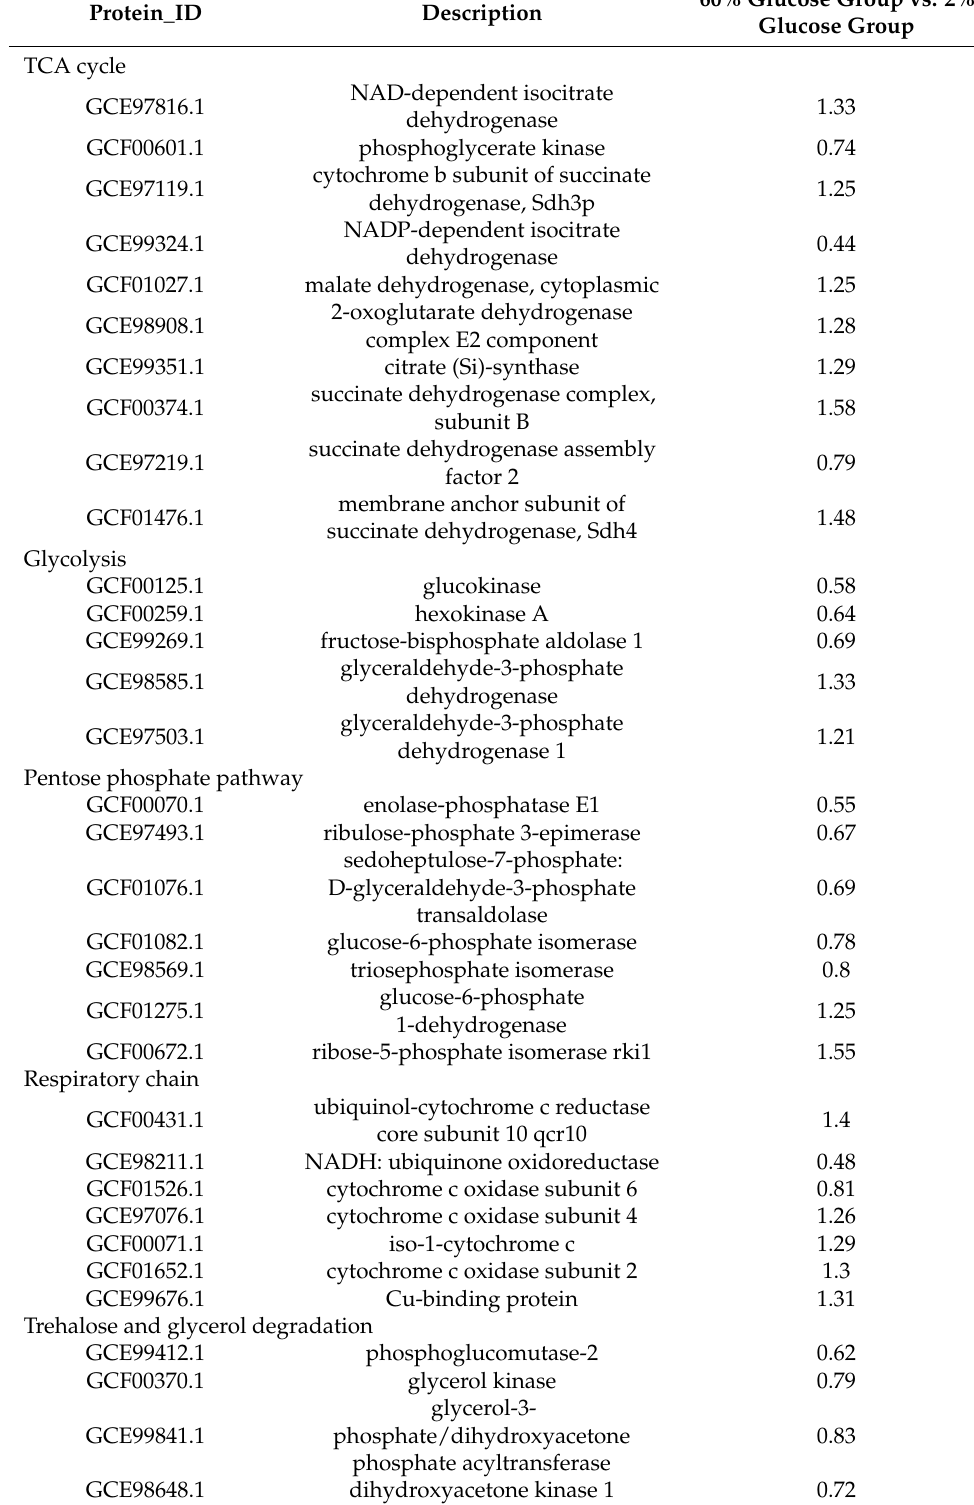
Table 3. Partial DEPs of Z. mellis in response to sugar